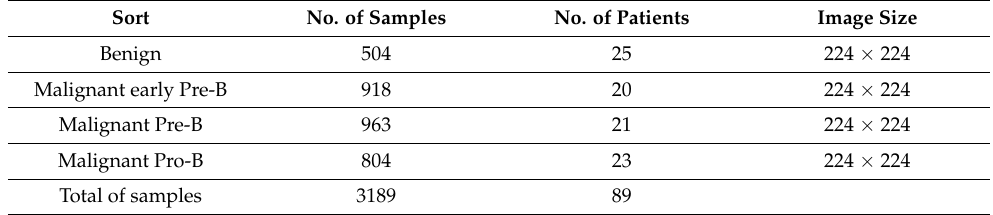
Table 1. The Dataset describing model.